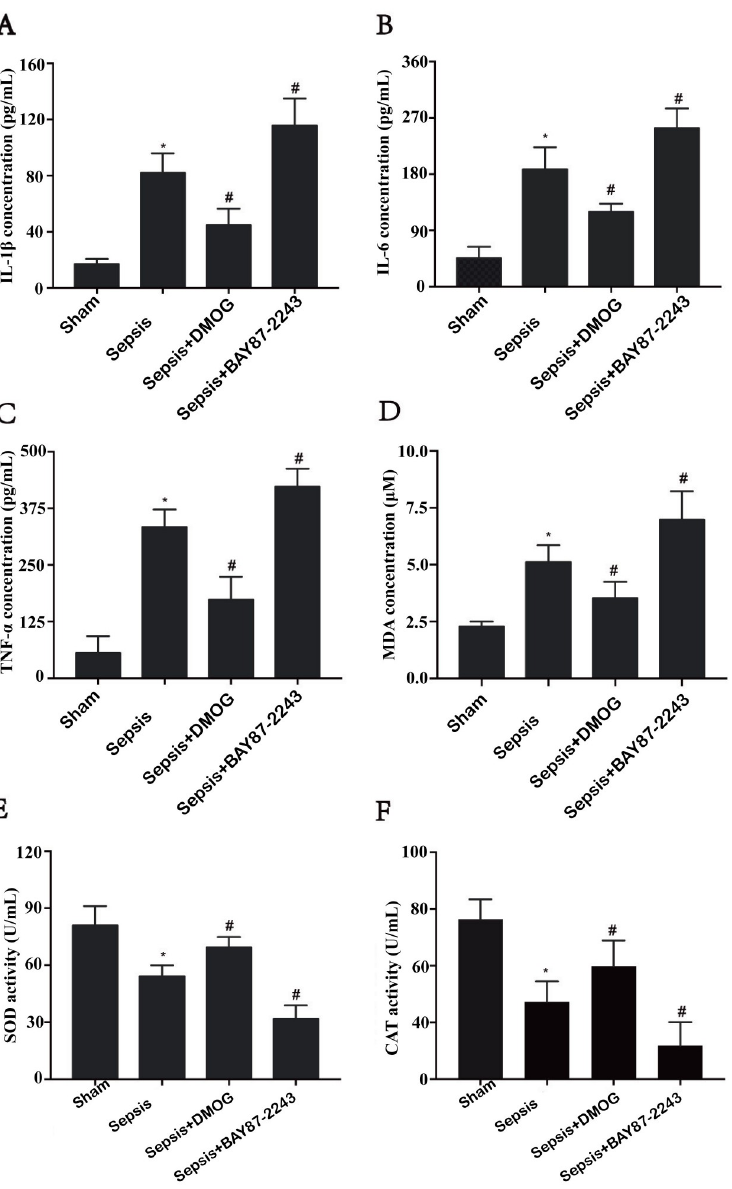
Fig 2. Effects of an HIF-1 α activation/inhibition on inflammation and oxidative stress in septic rats ( n = 6 except sepsis + BAY 87–2243 with n = 5). Data are expressed as the mean (SD). Changes in IL-6 (A), IL-1 β (B), and TNF- α (C) plasma concentrations; the MDA plasma content (D); and SOD (E) and CAT (F) activities in each group are depicted. � P < 0.05 compared with the sham group; # P < 0.05 compared with the sepsis